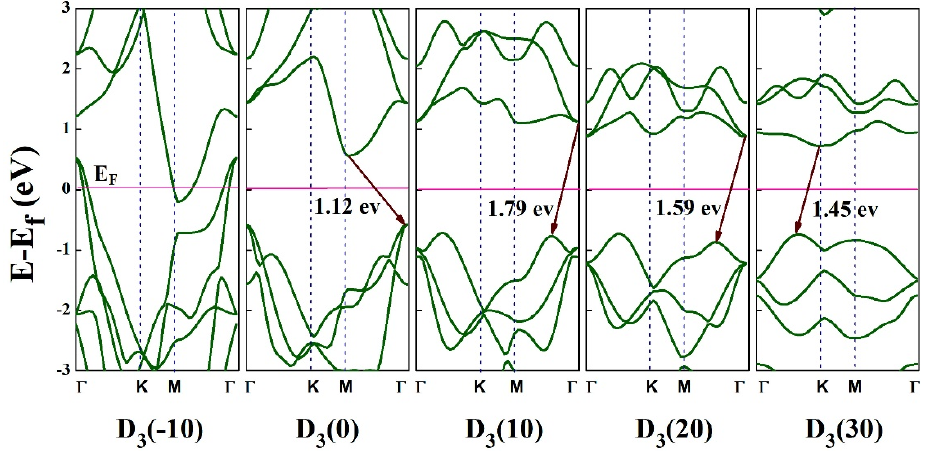
Figure 9. Band structure of the HfS 2 monolayer under D 3 deformation in the range of − 10% to 30%.